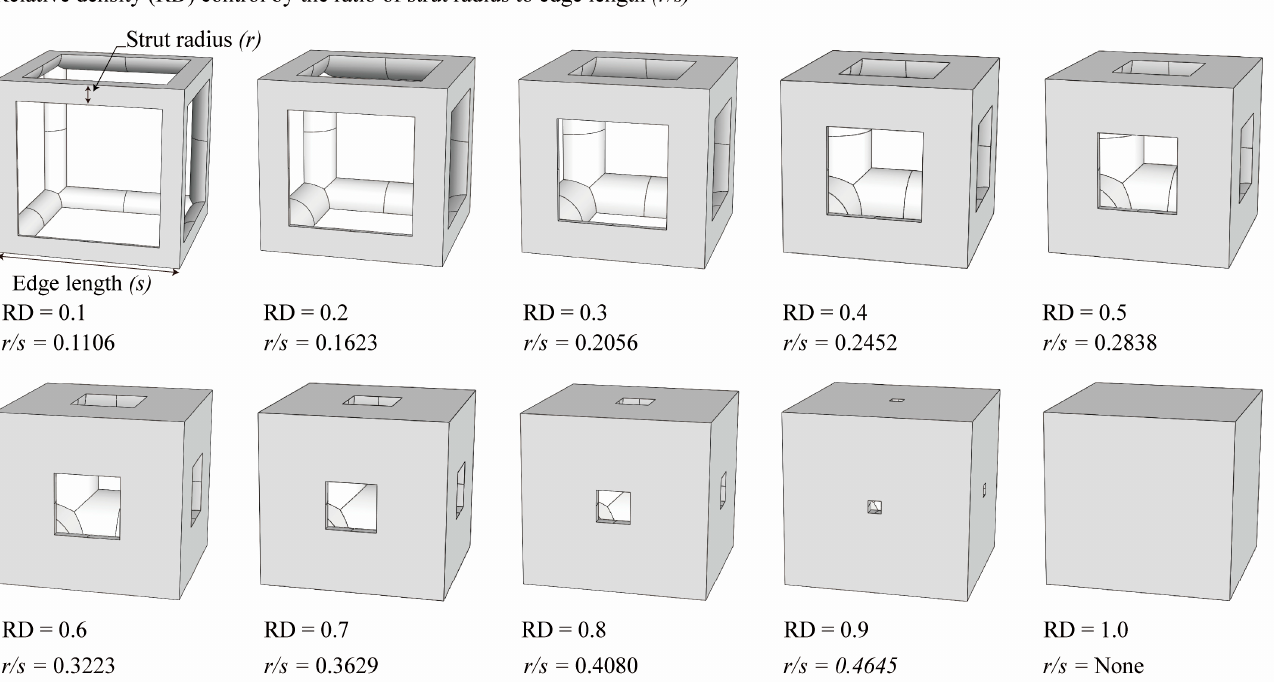
Figure 3. Relative density (RD) of the simple cubic unit cell controlled by the ratio of strut radius to edge length.